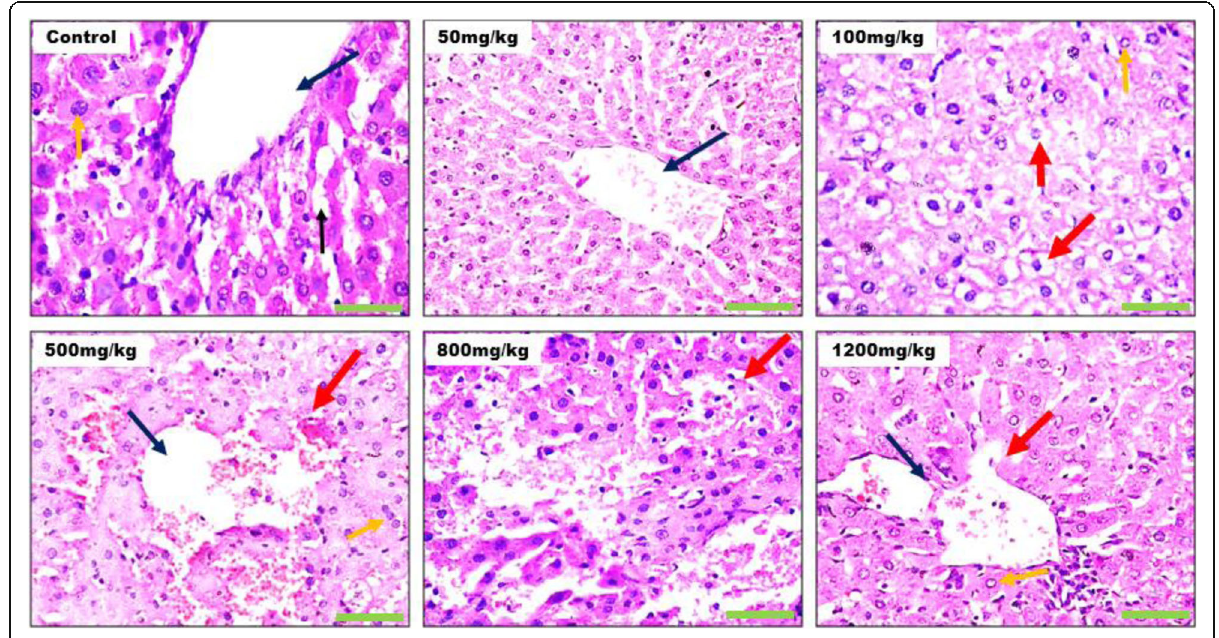
Fig. 1 Photomicrograph of a liver sections stained with Haematoxylin and Eosin (Mag. × 400). The Portal triad (blue arrow) composed of the hepatic vein and artery as well as the bile duct (PT), the well distributed hepatocytes (H) (yellow arrow) and hepatic sinusoids (black arrow) are demonstrated across study groups. Control treatment showed normal central venules without congestion, the morphology of the hepatocytes appear normal, the sinusoids appear normal with no observable form of infiltration and no observable pathological lesion seen. 50 mg/kg-1200 mg/kg treatments relative to control showed varied degree of hepatic injury that is dose dependent. In these groups, from mild to severe order; shows observable congested portal vein, the liver parenchyma showed area of harmorrhage, the morphology of the hepatocytes appear pyknotic, some show mild fat infiltration (red arrow) the sinusoids appear fibrotic with infiltration of inflammatory red cells (red arrow). Summarily, experimental group shows some degenerative changes that can be termed as necrosis, some mild fibrosis and hemorrhage characterized by the presences of infiltrated red hemorrhagic and inflammatory cells. Also observed is a distortion in the walls of the blood vessels (red arrow), pyknotic hepatocytes and signs of inflammation (red